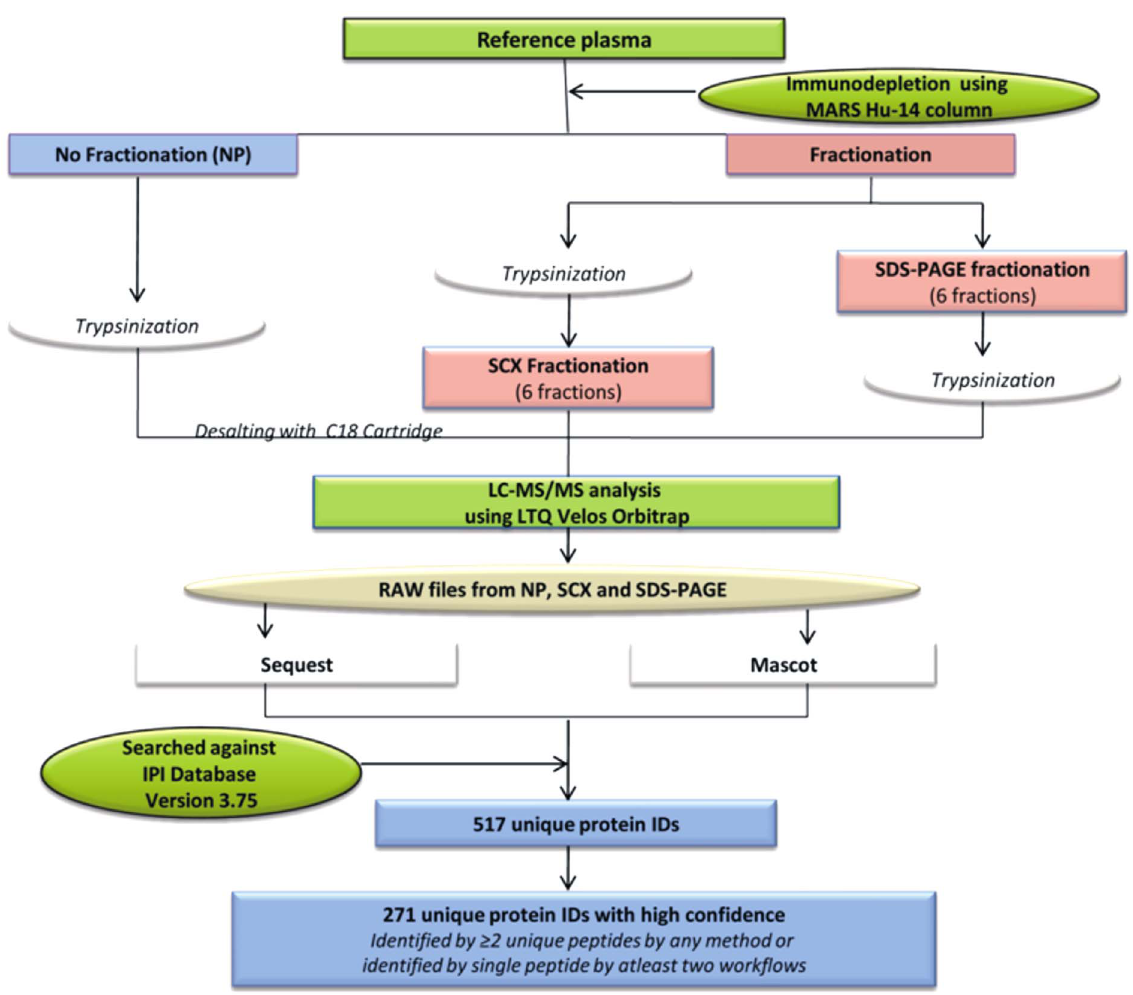
Figure 1. Experimental overview and bioinformatic analysis to study plasma proteome. Reference plasma sample was prepared by pooling equal volumes of plasma from 10 healthy individuals of either sexes and age group of 25–60 years. The sample was immunodepleted with 14 abundant proteins and analyzed using three different workflows- a) no prefractionation b) prefractionation at peptide level by strong cation exchange (SCX) chromatography and c) prefractionation at protein level by sodium dodecyl sulfate polyacrylamide gel electrophoresis (SDS-PAGE), using nano LC-MS/MS approach for in-depth human plasma proteome analysis. The analysis led to the identification of a total of 517 unique proteins identified from all the three workflows. A total of 271 proteins were identified with high confidence i.e. identified with $ 2 unique peptides or by a single peptide identified in any of the two workflows.